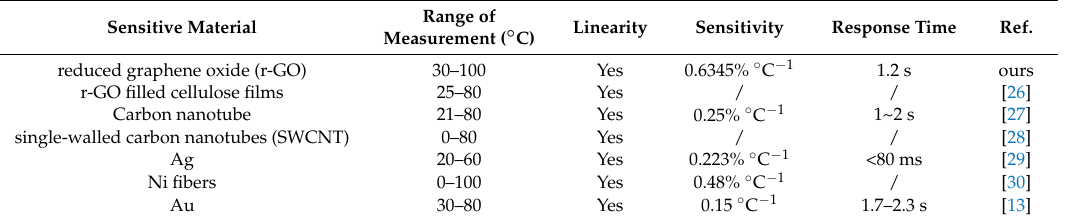
Table 1. Some kinds of flexible temperature sensors and their performances.